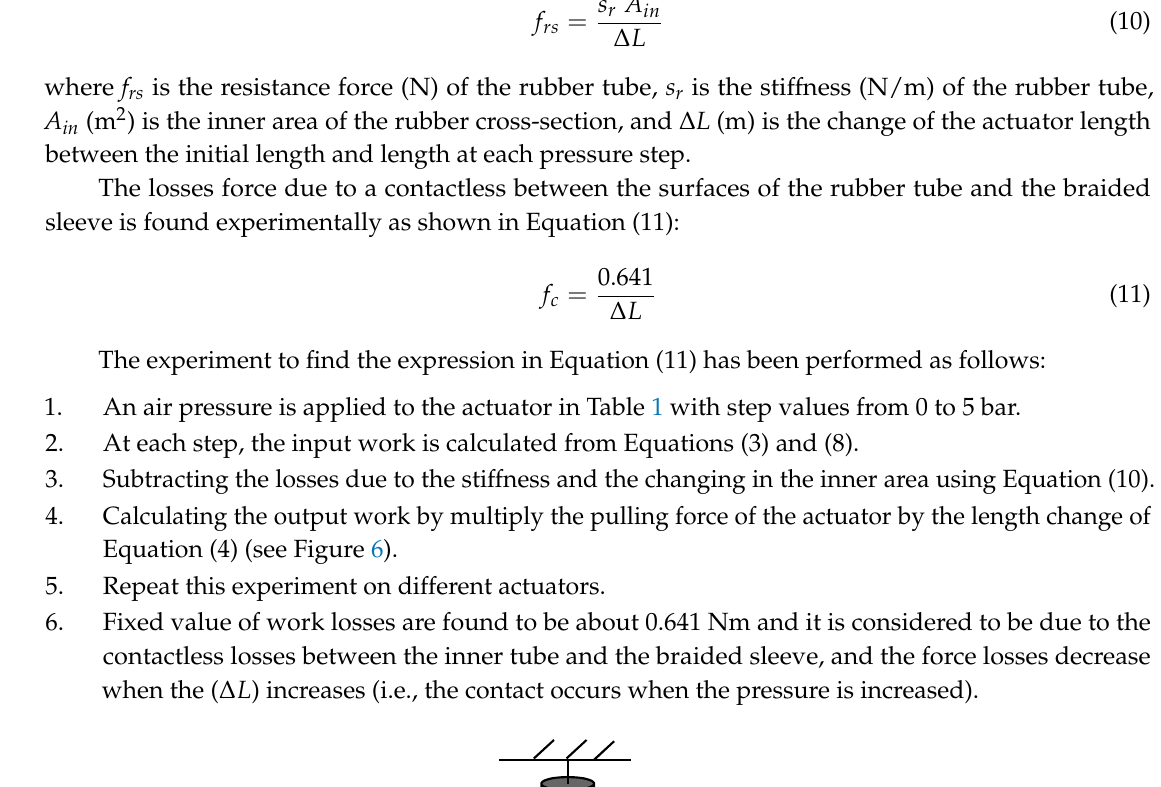
Figure 5. The cross-section of the PMA structure.